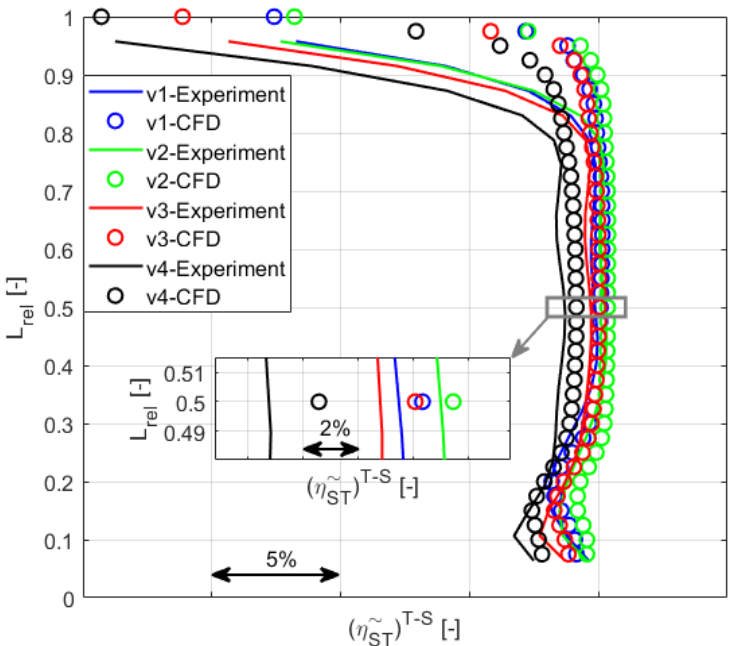
Figure 8. Comparison of radial distributions of mass-averaged turbine stage efficiency (T-S).